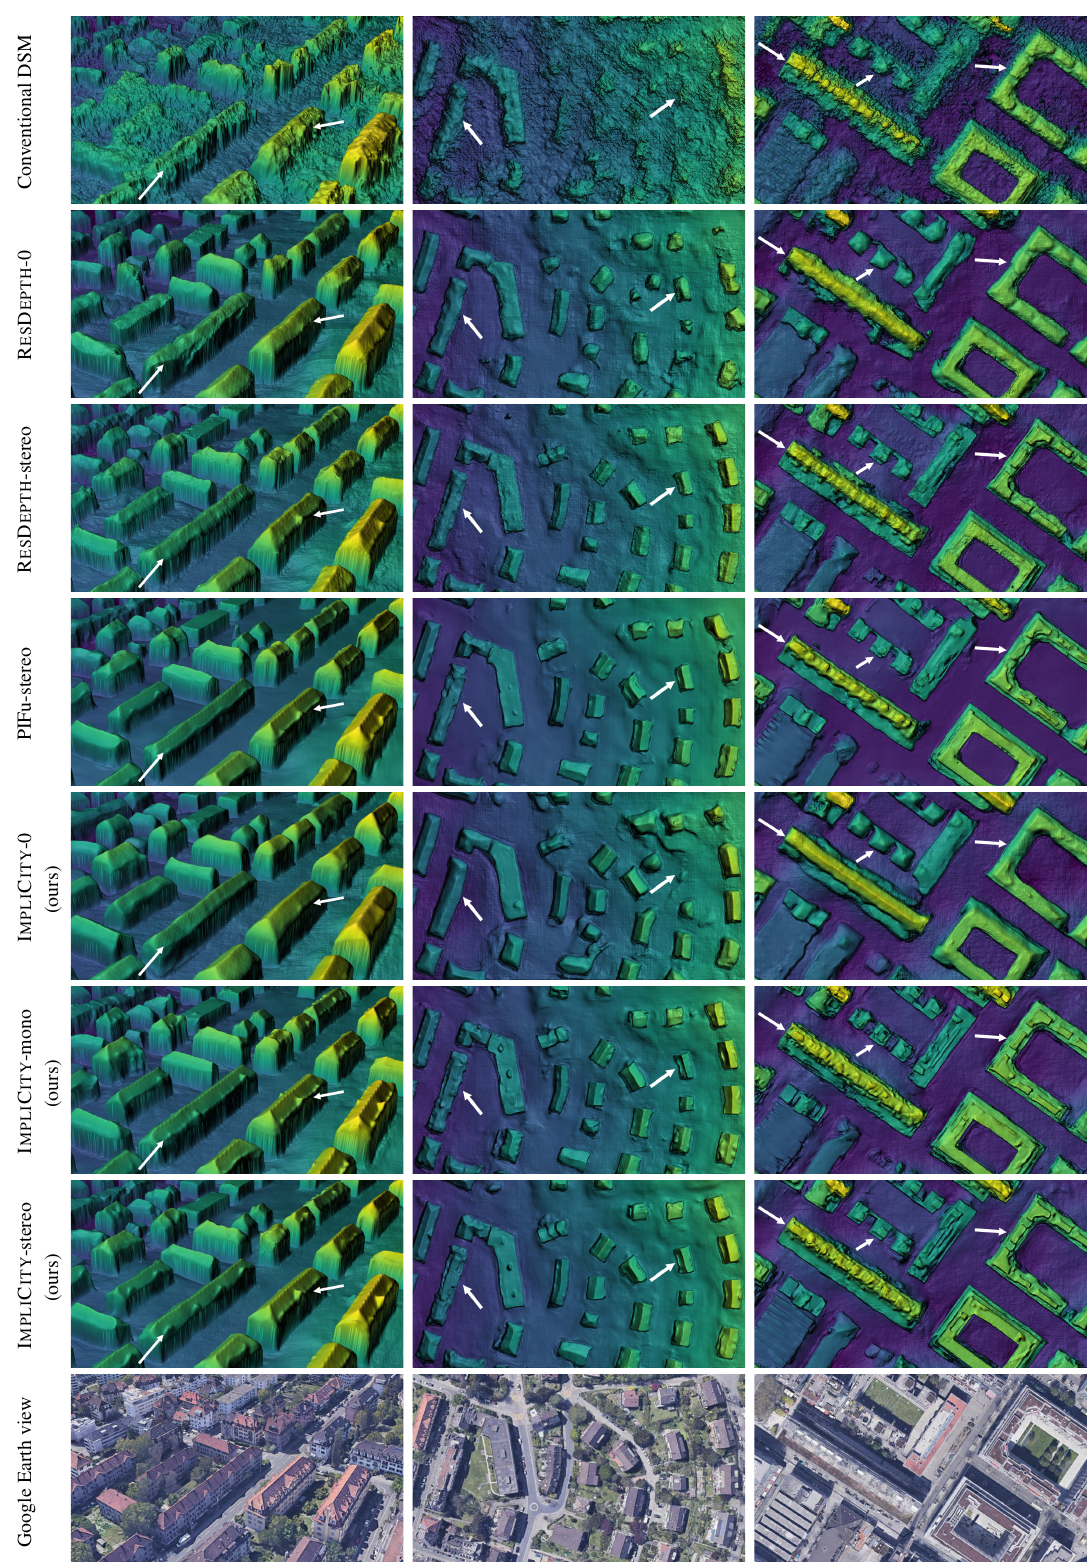
Figure 3. Visual comparison of different I MPLI C ITY variants with selected baselines. Heights are color-coded from blue to green to yellow. All examples are from the test